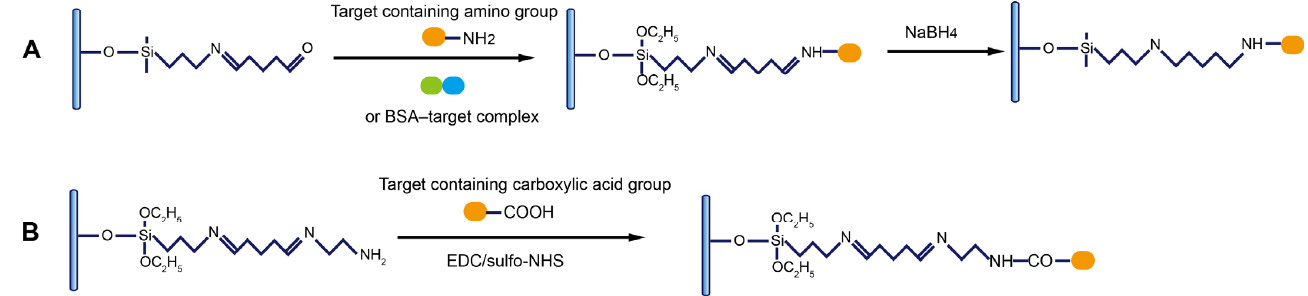
Figure 7. The representative methods to modify the fi ber with targets containing ( A ) amino or ( B ) carboxylic acid groups. ( B ) carboxylic acid